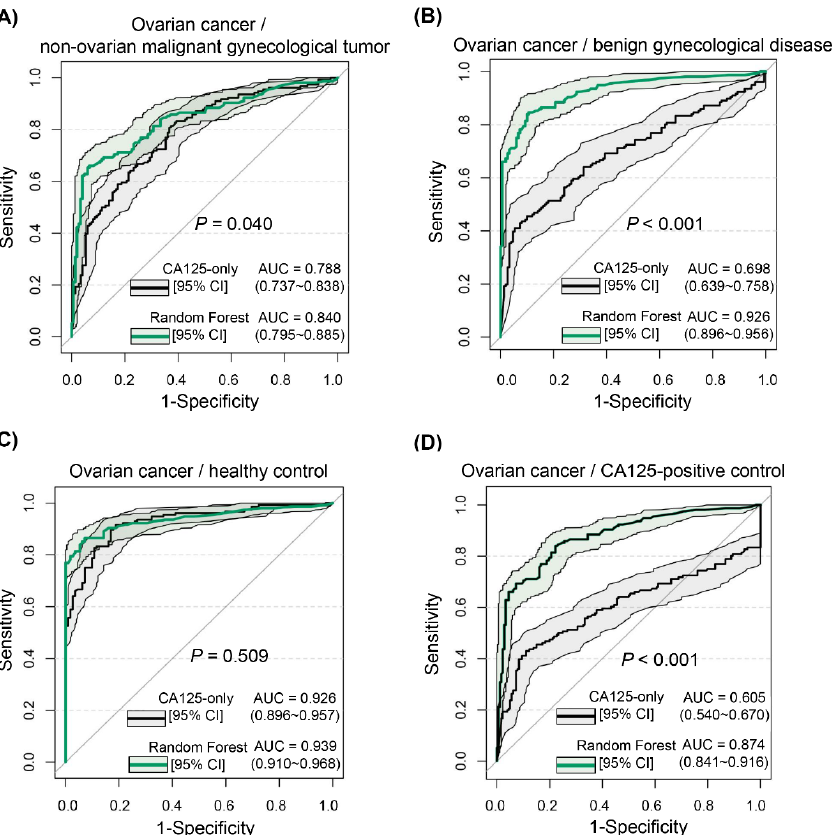
Figure 6. Receiver operating characteristic curves of random forest-based differential diagnosis of ovarian cancer versus different control populations. ( A ) Ovarian cancer versus non-ovarian malignant gynecological tumors. ( B ) Ovarian cancer versus benign gynecological diseases. ( C ) Ovarian cancer versus those with normal physical examination. ( D ) Ovarian cancer versus CA125-positive controls.